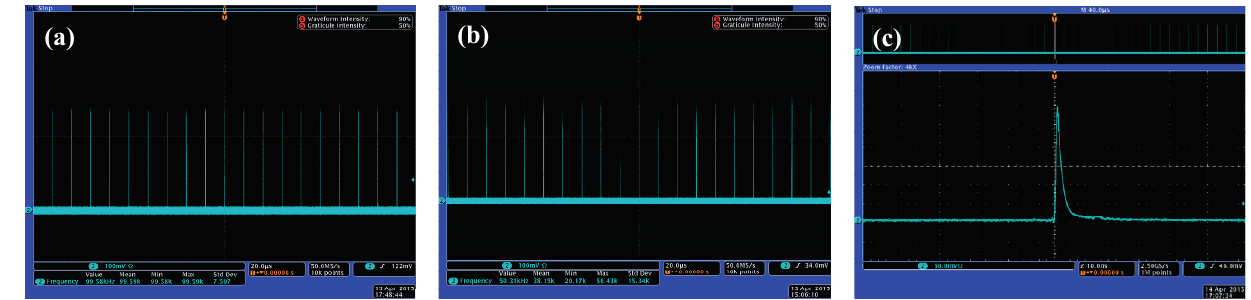
Figure 5. Oscilloscope traces of ( a ) the pulse train at 195 ns regeneration amplification time; ( b ) the pulse train of unstable multi-period phenomenon; ( c ) a single pulse shape at 195 ns regeneration amplification time.